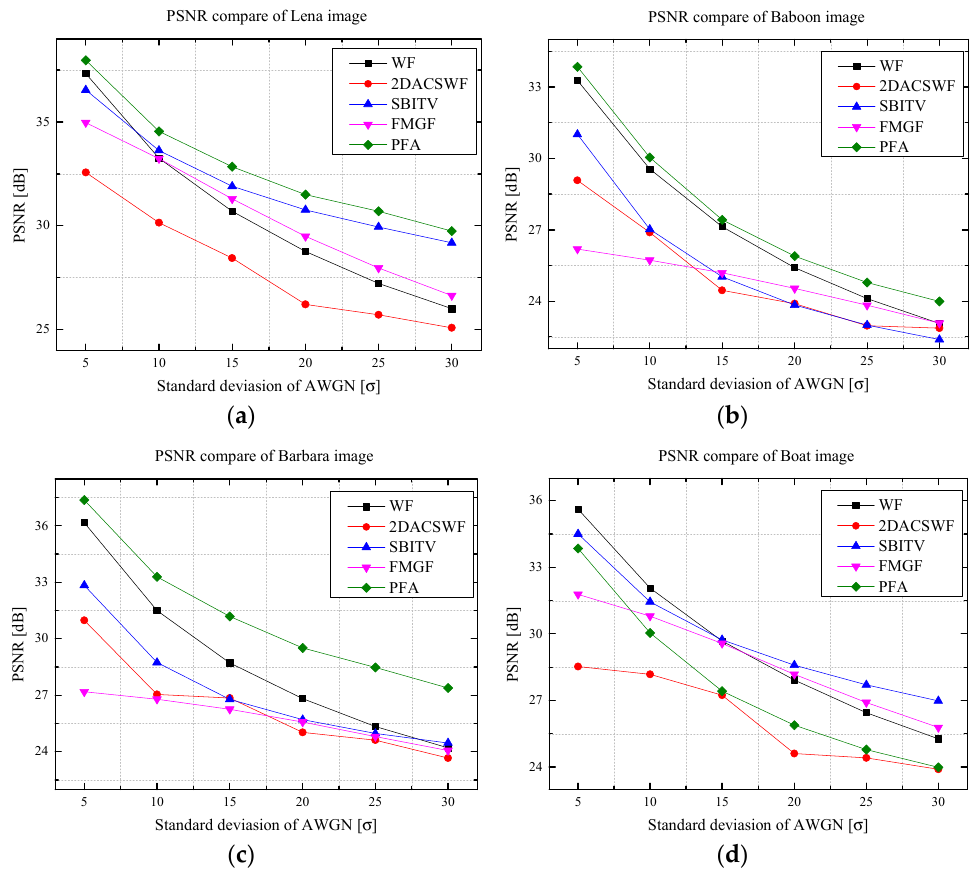
Figure 10. PSNR graph of simulation result. ( a ) PSNR graph of Lena image. ( b ) PSNR graph of Baboon image. ( c ) PSNR graph of Barbara image. ( d ) PSNR graph of Boat image.